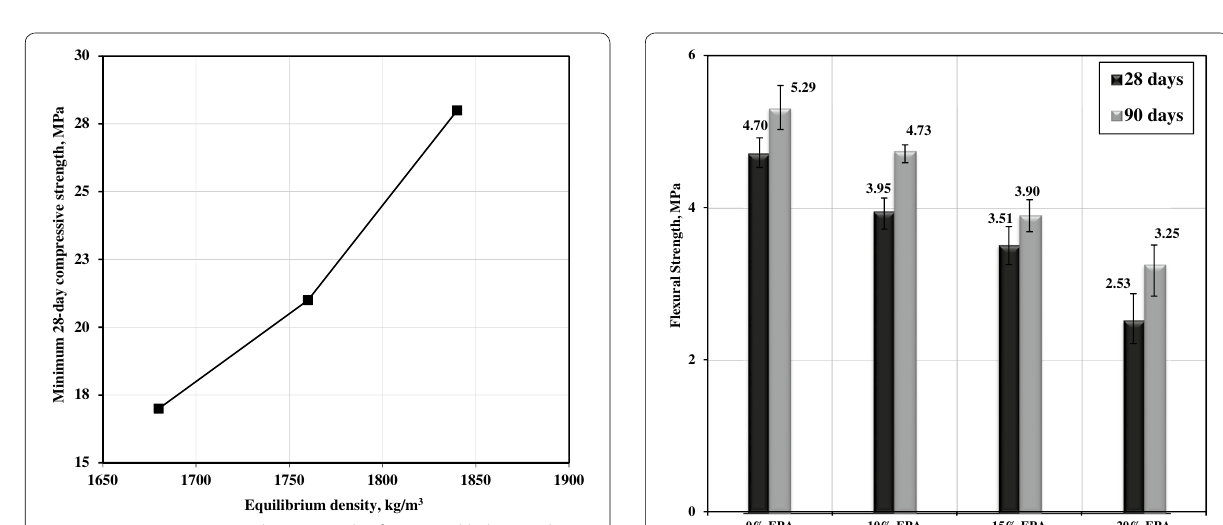
Fig. 7 ASTM minimum 28 days strength of structural light-weight concrete. Fig. 8 Flexural strength of concrete prepared with varying EPA